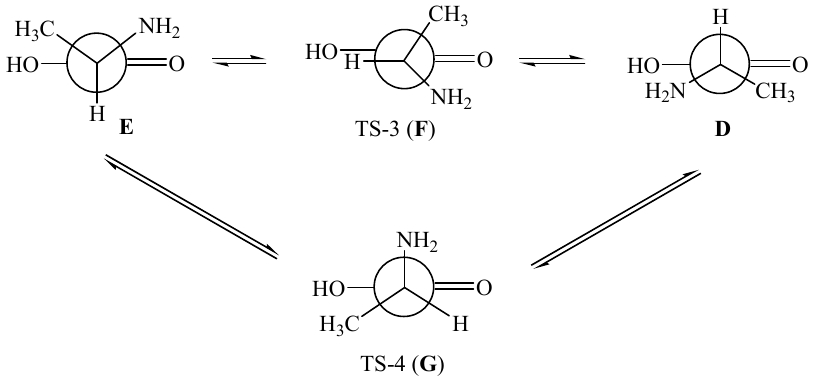
Molecules 2020 , 25 , x FOR PEER REVIEW